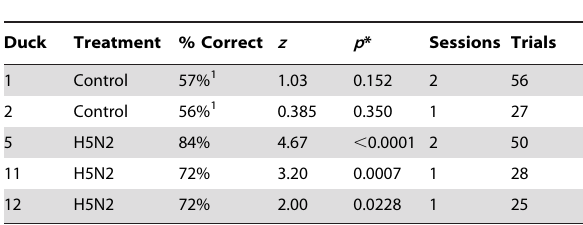
Table 3. Bioassay results of unrewarded generalization